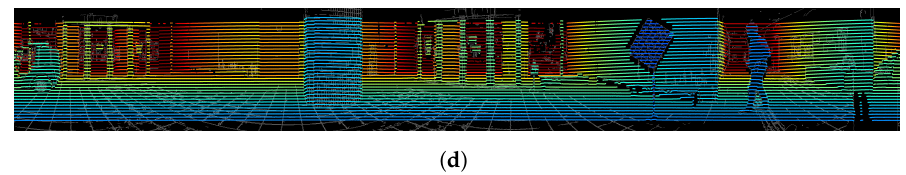
Figure 19. Re-projection results. ( a ) All re-projected points on the color panoramic image and colored by intensity; ( b ) All re-projected points on the color panoramic image and colored by distance; ( c ) Re-projected result on edge extracted image of all points colored by intensity; ( d ) Re-projected result on edge extracted image of all points colored by distance.